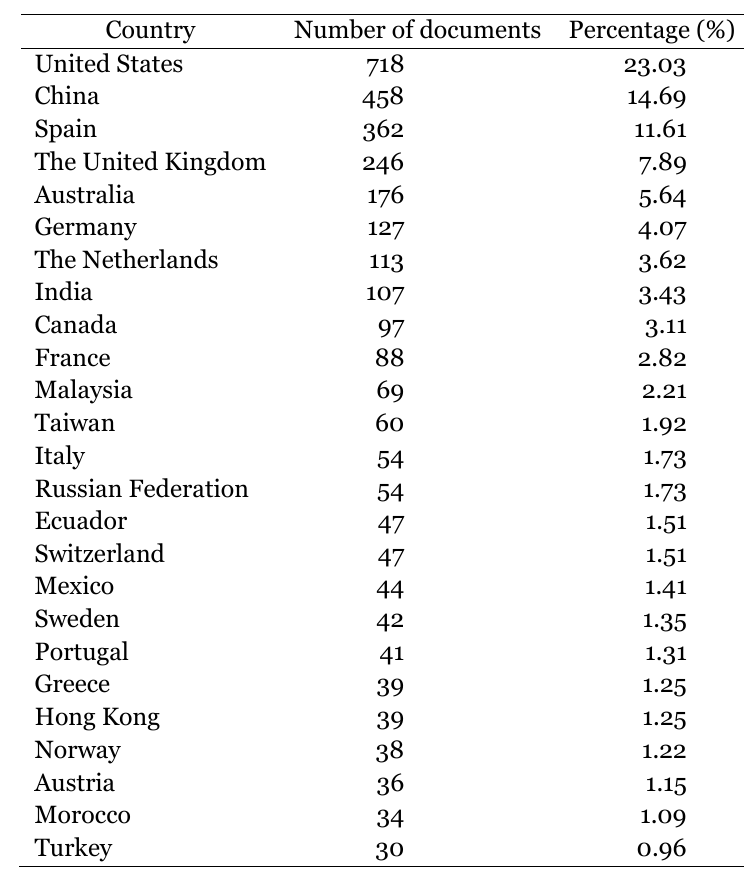
Table 8 Geographic Origins of MOOCs